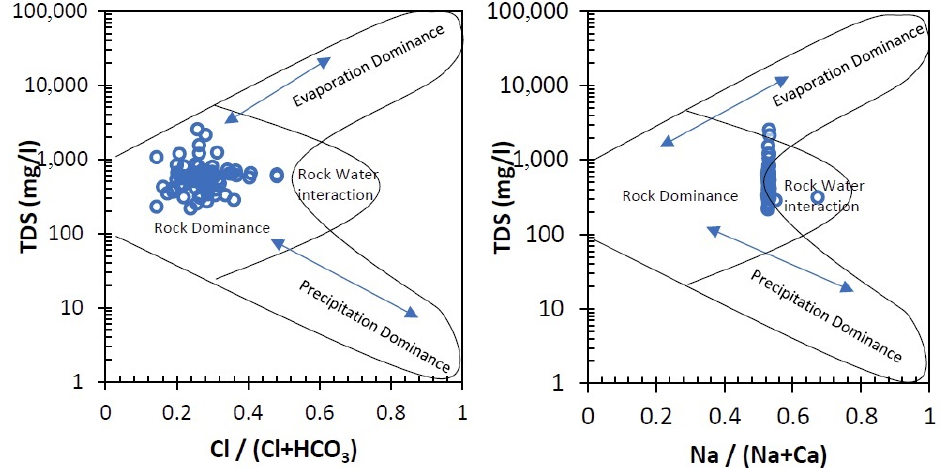
Figure 3. Gibbs diagram for groundwater samples collected from Târgovi ş te Plain.